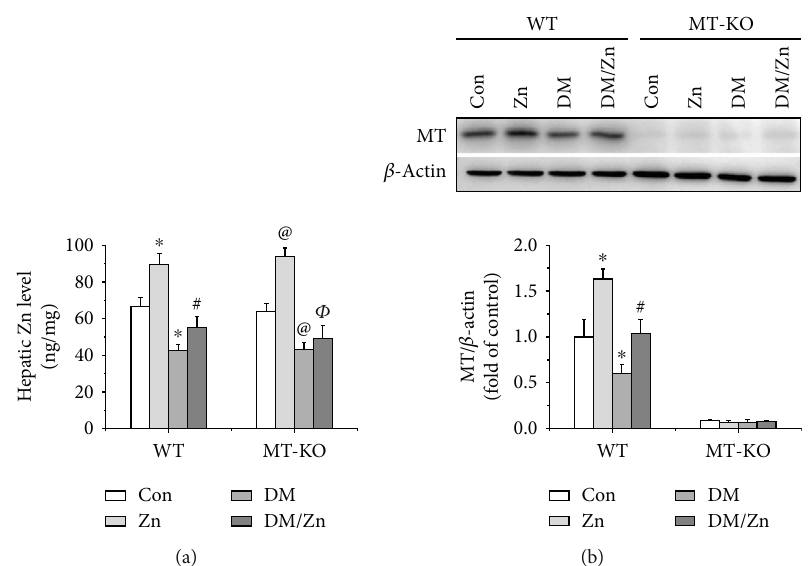
Figure 1: The e ff ects of zinc supplementation on hepatic zinc and MT in both WT and WT-KO mice under type 2 diabetic condition. HFD/STZ strategy was applied in both WT and MT-KO mice to induce type 2 diabetes. Then, the diabetic and nondiabetic mice were treated with ZnSO4 for 3 months. After sacri fi ce, the liver tissue was isolated for hepatic zinc level measurement by an atomic absorption spectrophotometer (a). Western blot was also applied to detect hepatic MT level among groups (b). Data are presented as the mean ± standard deviation ( n = 8 /group). ∗ P < 0 : 05 vs. the control (Con) group in WT mice; # P < 0 : 05 vs. the type 2 diabetes (DM) group in WT mice; @ P < 0 : 05 vs. the control (Con) group in MT-KO mice; Ф P < 0.05 vs. the control (DM) group in MT-KO